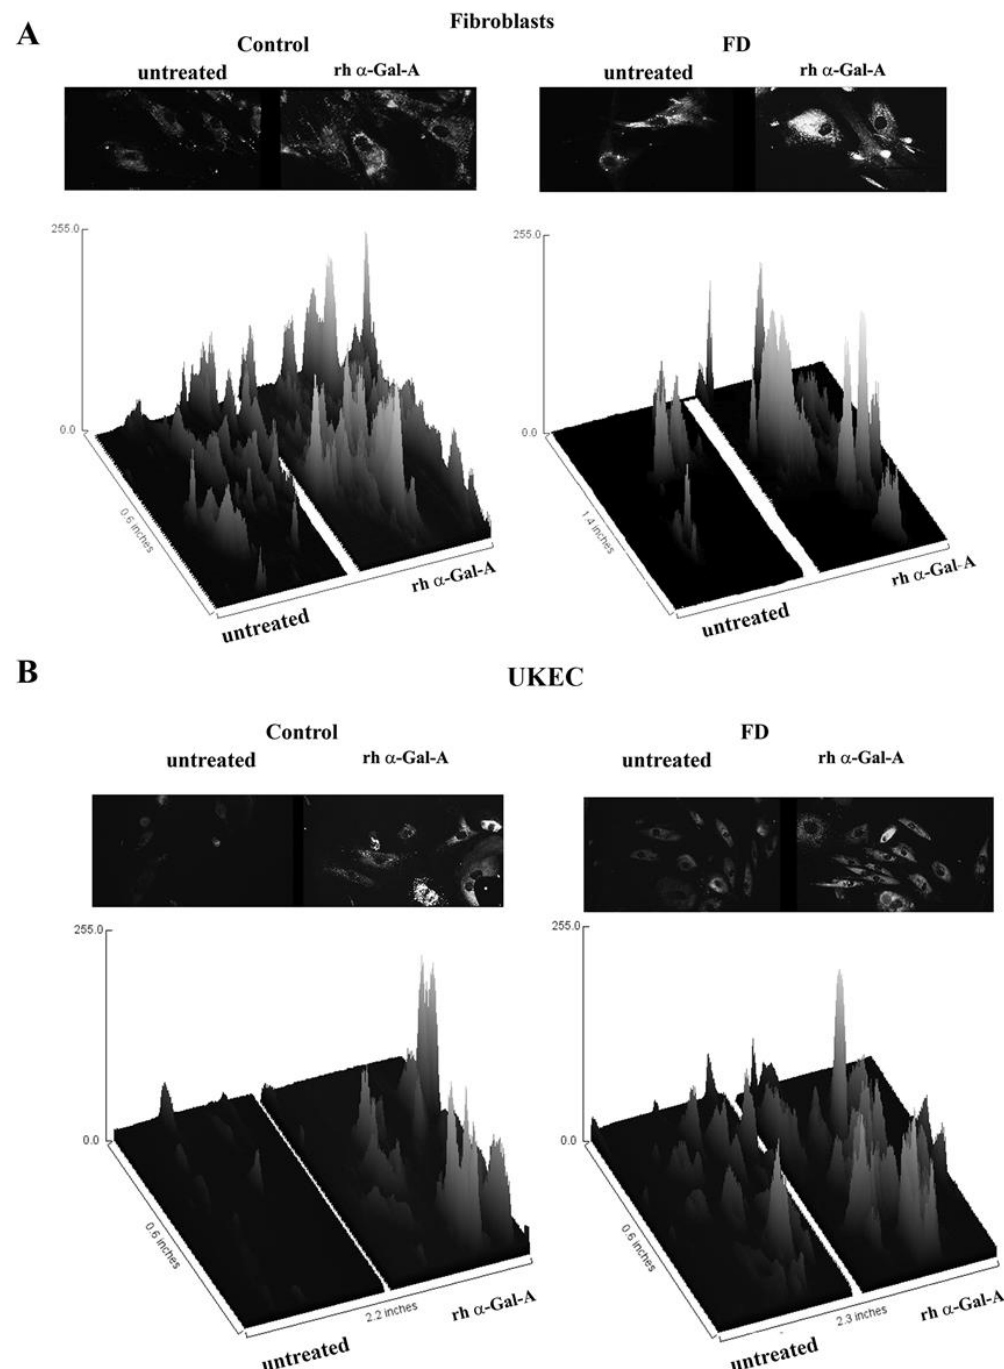
Figure 8. The interactive 3D surface plots displayed a three-dimensional graph of the intensities of pixels (Z) of autophagy in grayscale images. Immunofluorescence images of control vs. FD fibroblasts ( A ) and UKEC cells ( B ) treated with fluorescence-labeled rh-α-Gal-A were stained with DALgreen autophagy dye. The autophagy images used in Figure 7 were converted to 2D gray color images, and then interactive 3D surface plots were built using the ImageJ program. 2D and 3D images of control and FD fibroblast are displayed.